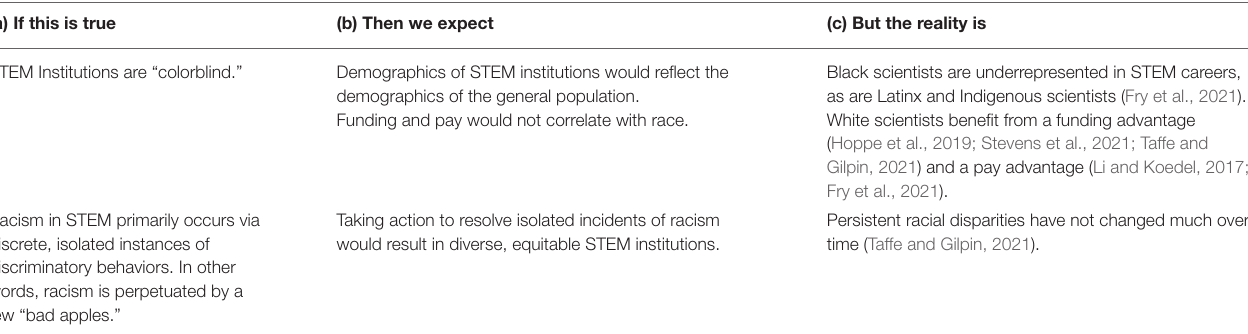
TABLE 2 | Common perceptions about inequality in STEM institutions (a) can be evaluated via associated expectations (b). However, persistent disparities in STEM (c) suggesting that STEM institutions are not “colorblind,” and that racism in STEM is a systemic cultural problem. (a) If this is true (b) Then we expect STEM Institutions are